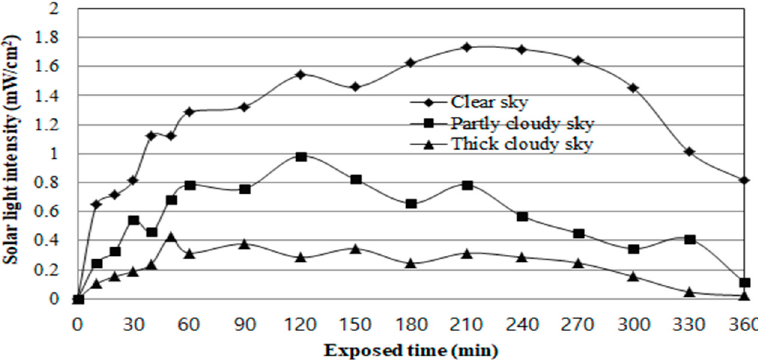
Figure 7. Solar light intensity vs. exposed time.